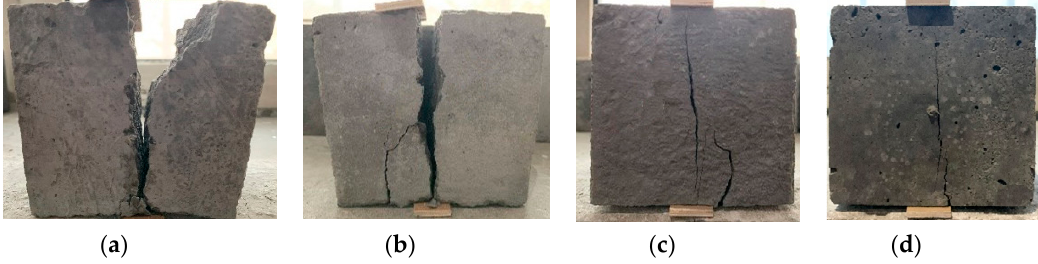
Figure 8. The splitting tensile failure morphology of LWACs—( a ) plain sample, ( b ) 0.5% BF, ( c ) 1% BF, ( d ) 1.5% BF.